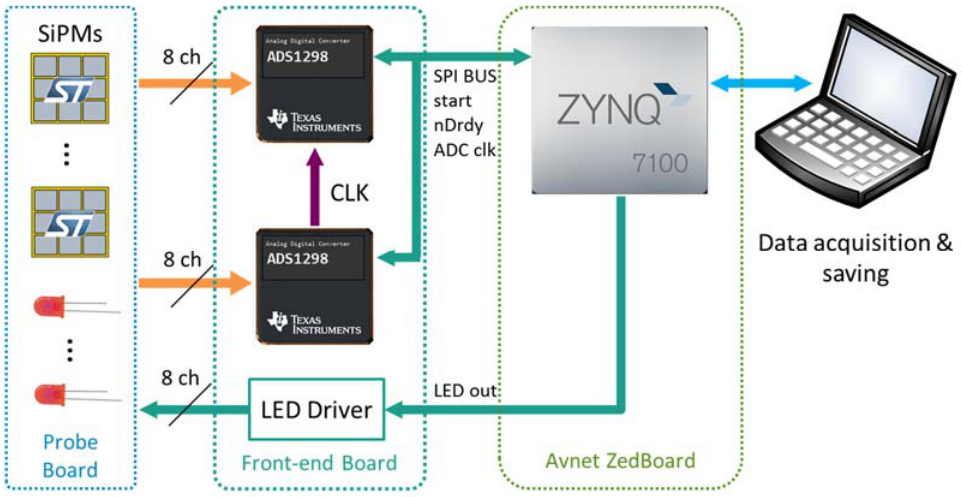
Figure 1. Block diagram of the overall system architecture.